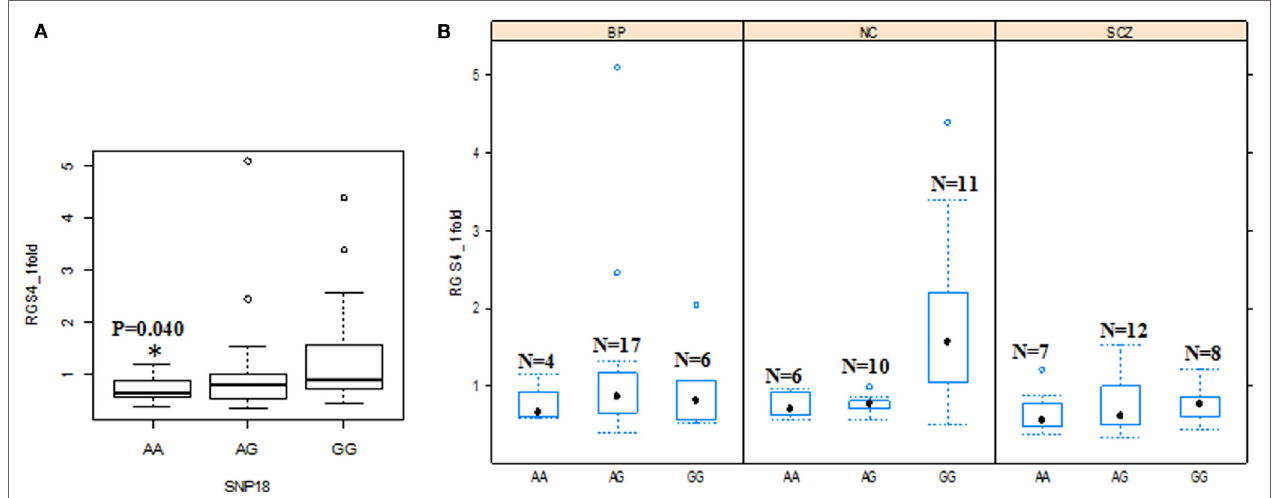
FigUre 6 | effects of snP18 genotypes on RGS4-1 mrna expression . (a) Among all the groups, the individuals with the genotype AA of SNP18 had lower mRNA expression of RGS4-1 compared with the subjects with genotype GG of SNP18 [ F (3,77) = 3.86 overall p = 0.0126; SNP18 genotype p = 0.0413]. (B) In SCZ, the subjects with genotype GG of SNP18 had lower mRNA expression level of RGS4-1 compared with the subjects with the same genotype GG of SNP18 in NC ( p =